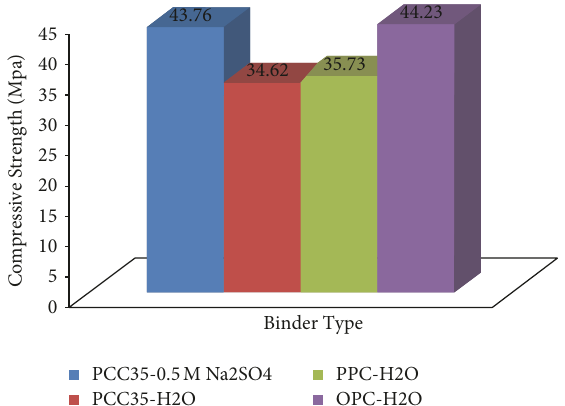
Figure 2: Percentage gain in compressive strength versus binder